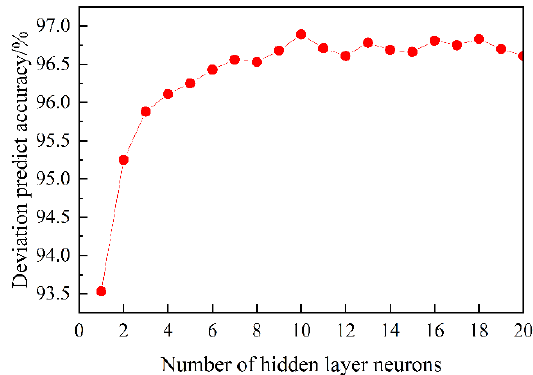
Figure 4. The effect of hidden-layer neuron numbers.